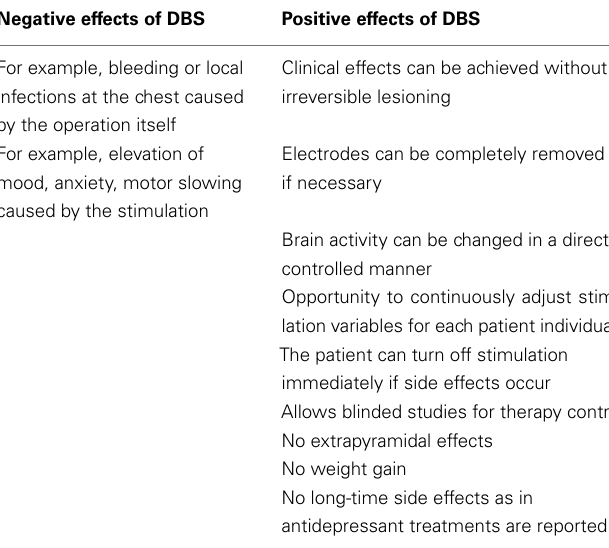
Table 1 | Possible side effects of DBS in OCD or